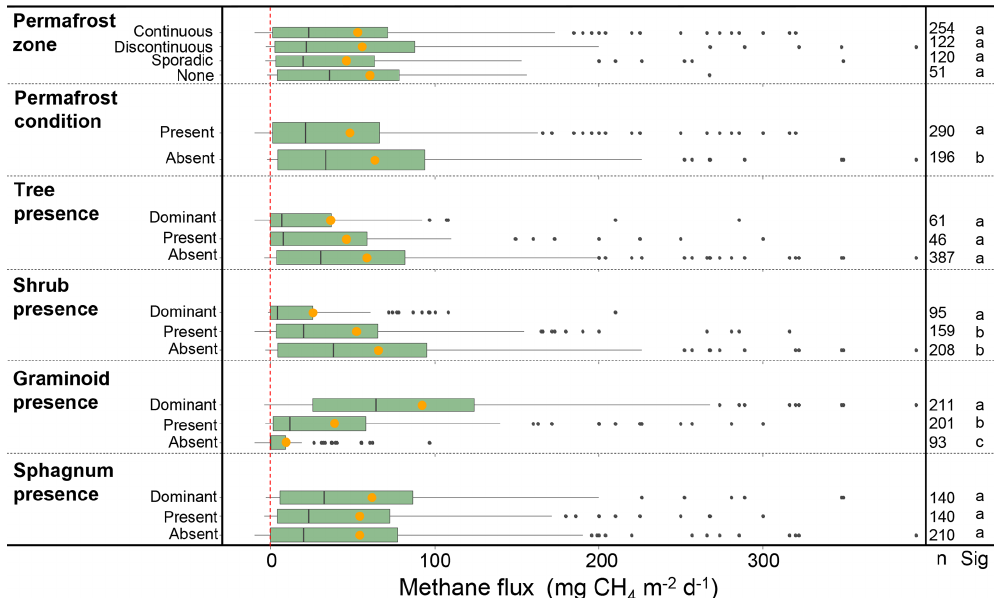
Figure 8. Warm-season CH 4 fluxes classified by categorical variables. Orange circles represent mean flux values. The number of sites for each category is represented in the column to the right ( n ), and statistical differences among the categories are indicated by the letters (Sig), wherein bars with the same letters are not significantly different. Permafrost zones are from Brown et al. (2002). Permafrost condition represents the presence of permafrost in the top 2m as reported by the authors. See text for definitions used to classify vegetation cover. Outlier fluxes greater than 380 are not shown.